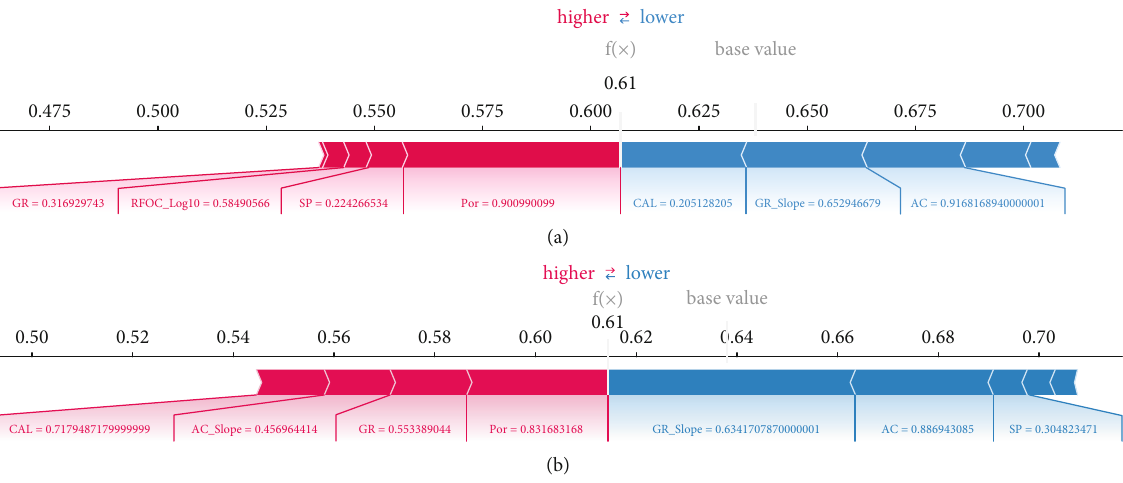
Figure 8: Single sample model explanation results by SHAP. (a) Sample no. 20. (b) Sample no. 25.